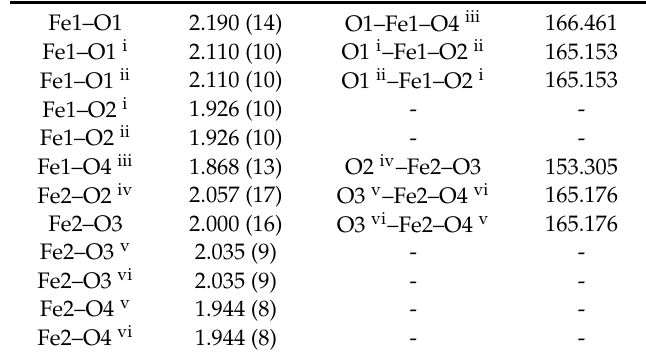
Table 2. Selected bond lengths (Å) and valence angles ( ◦ ) of Ge-akagan é ite after the Rietveld refinement. Fe1 is possible site for Ge by equivalent substitution.